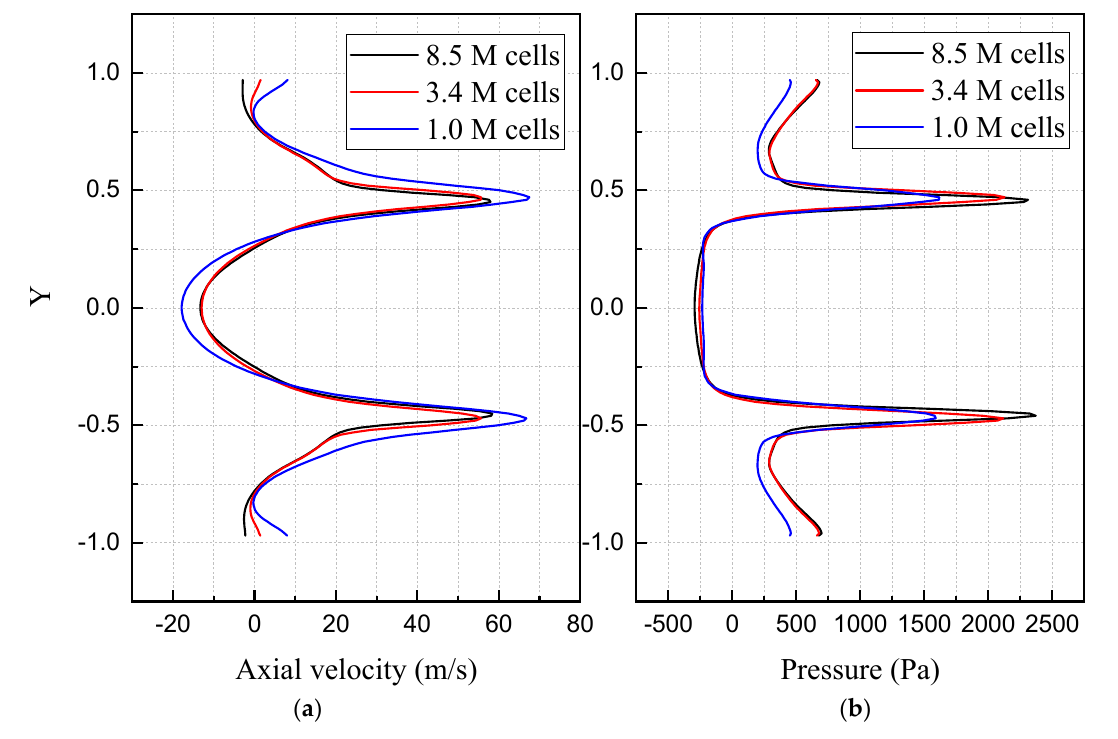
Figure 3. Grid sensitivity analyses. ( a ) Axial velocity. ( b ) Pressure.